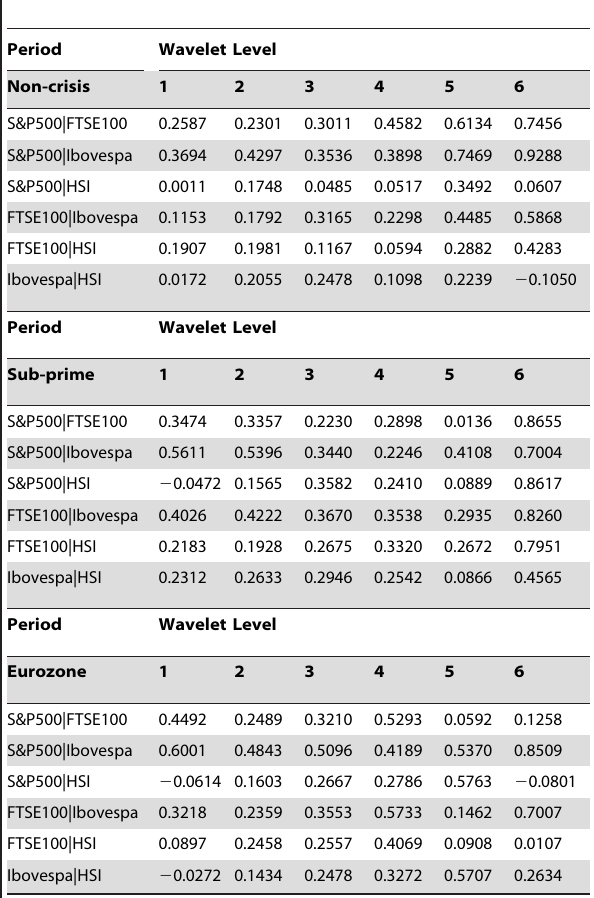
*Wavelet level n corresponding to 2 n-1 trading days.